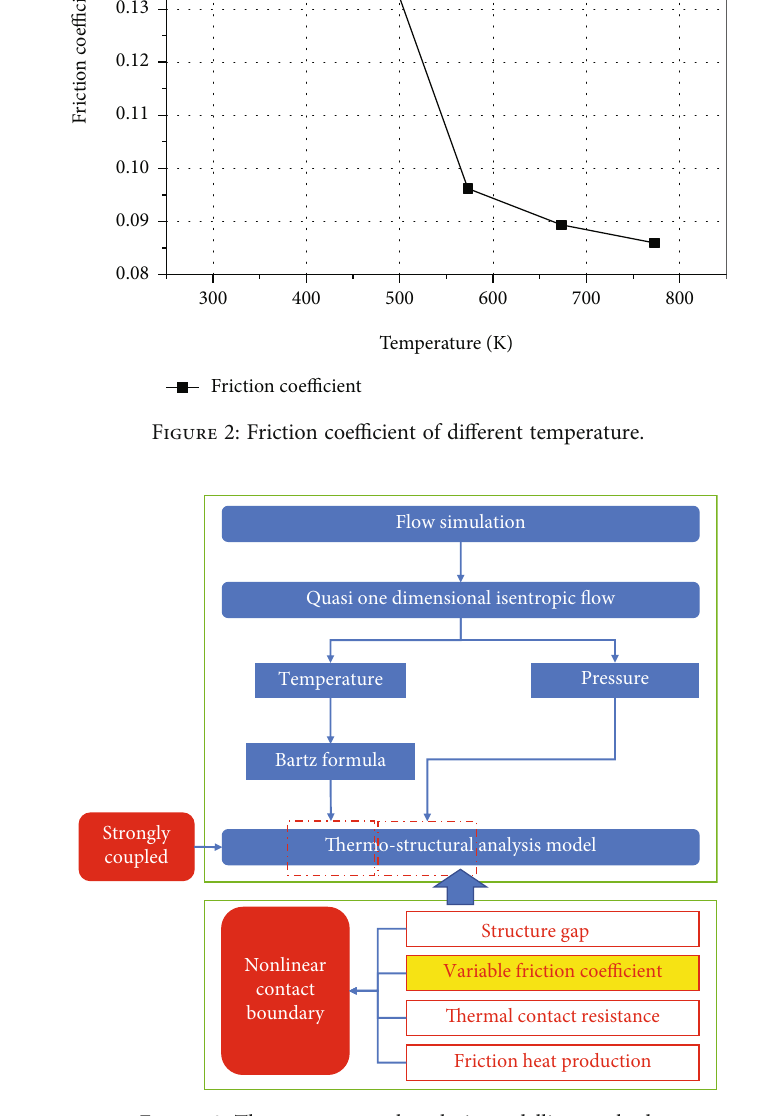
Figure 3: Thermo-structural analysis modelling